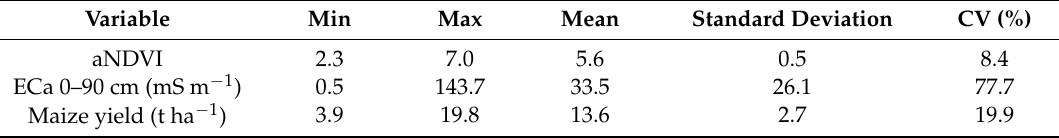
* CV: Coefficient of